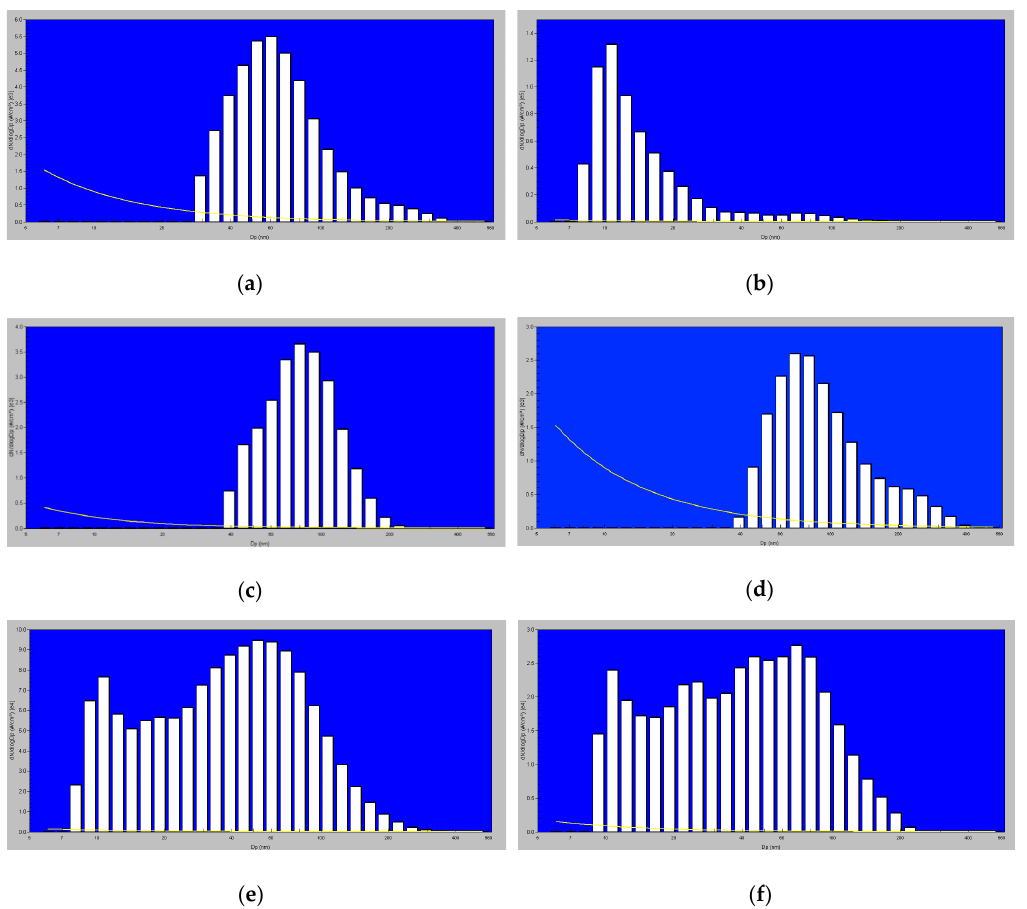
Figure 7. Typical aerosol distribution profiles determined ( a,b ) in the morning (07:00–09:00), ( c,d ) in rush hours (17:00–19:00), and ( e , f ) in the evening (20:00–22:00) during workdays at the Monte Terminillo rush hours (17:00–19:00), and ( e,f ) in the evening (20:00–22:00) during workdays at the Monte site and in downtown Rome, Terminillo site and in downtown Rome, respectively.